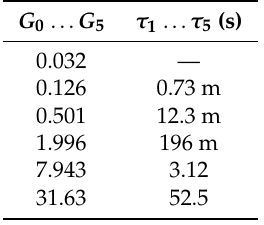
Table 1. Values of gain factors and time-constants for implementing the fractional-order